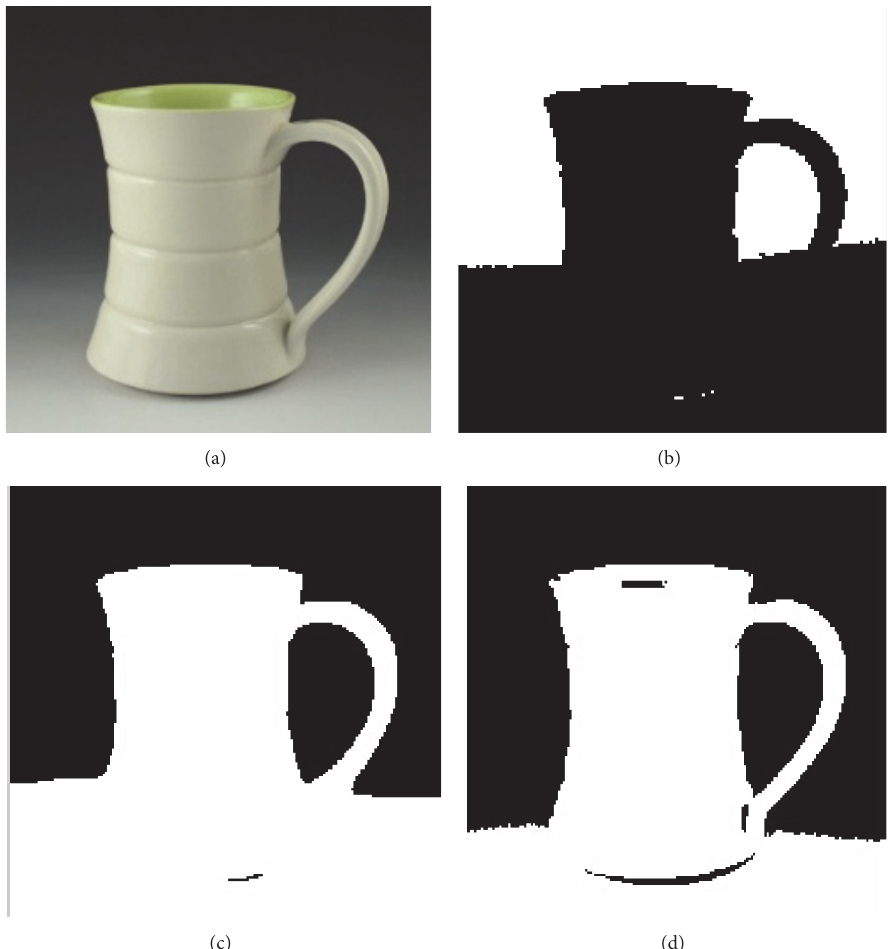
Figure 4: (a) Primary image. (b) CV segmentation. (c) BFV segmentation. (d) TLBO-BFV segmentation.